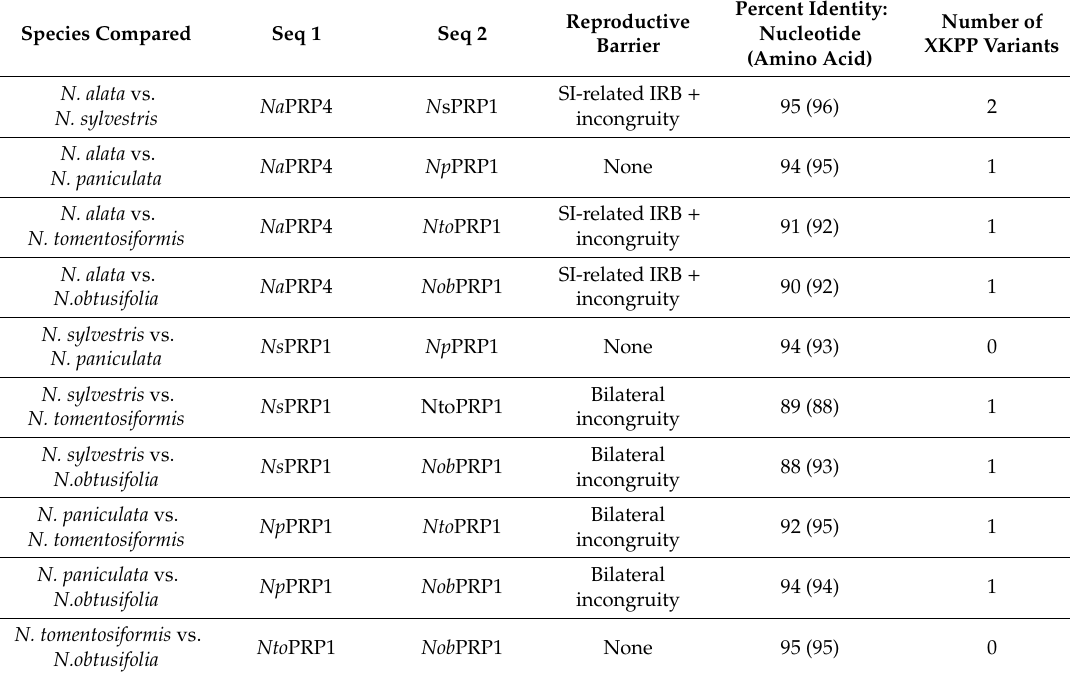
motif sequence caused by non-synonymous